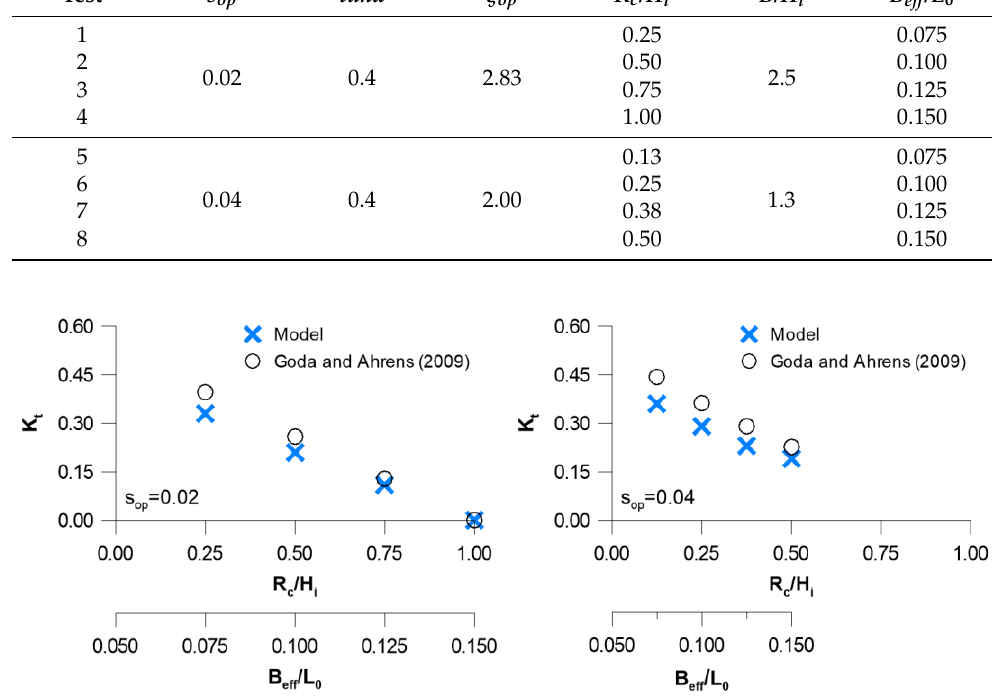
Figure 4. Wave transmission at emerged LCS: comparison between between K t values as estimated following [34] and as resulted from the presented advanced nearshore wave propagation model runs (see Section 2.3).